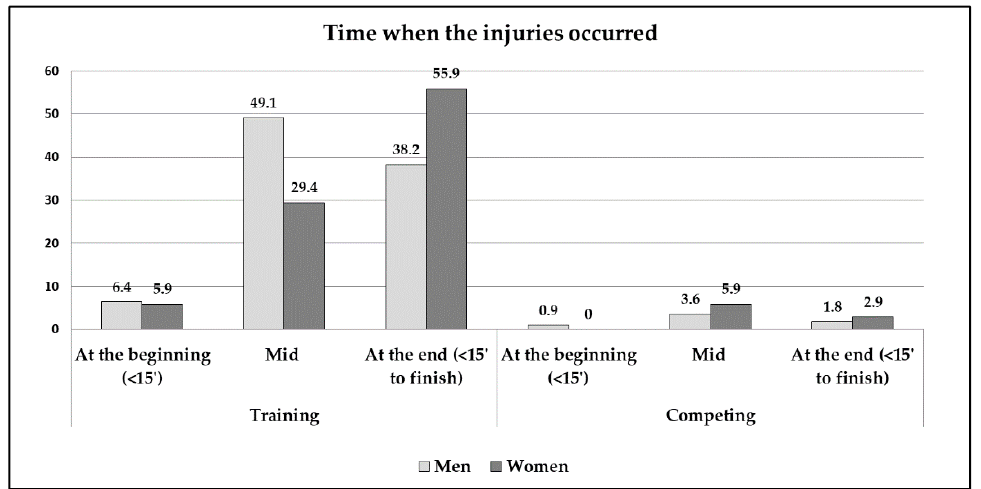
Figure 1. Incidence of injuries according to the anatomical segment. Figure 2 indicates that, in the males, the injuries occurred more frequently in the central period of the training sessions, whereas, for the females, the greatest frequency corresponded to the last 15 min of the training sessions.